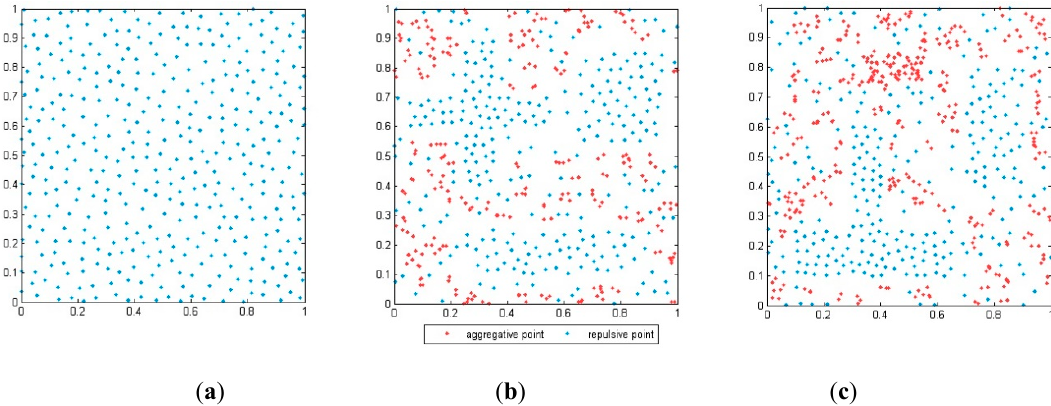
Figure 6. Extraction of repulsive points. Blue points represent repulsive points with respect to d , and red points represent aggregative components. ( a ) repulsion; ( b ) repulsion and noise; (c) aggregation, repulsion and noise.